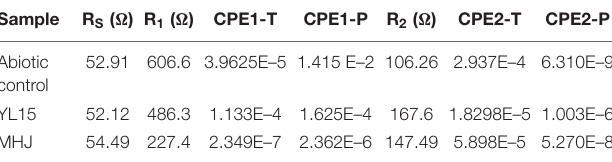
TABLE 2 | Fitting results using the analog circuit R S (R 1 CPE1) (R 2 CPE2) of the chalcopyrite